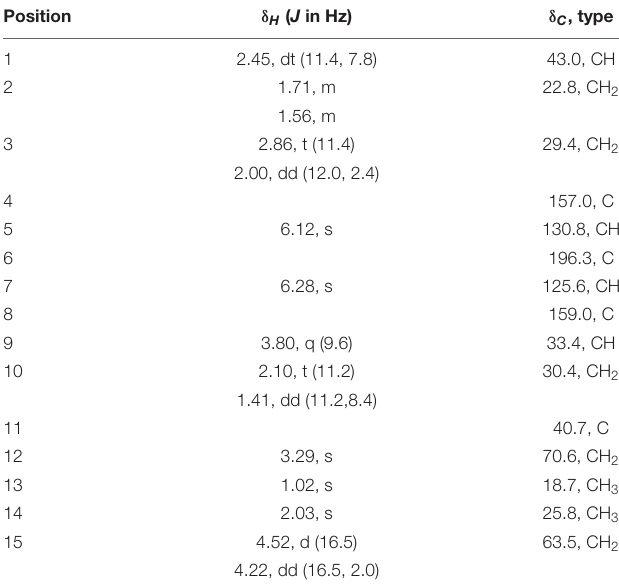
TABLE 2 | 1 H (400 MHz) and 13 C NMR (100 MHz) data for 3 in methanol- d 4 .